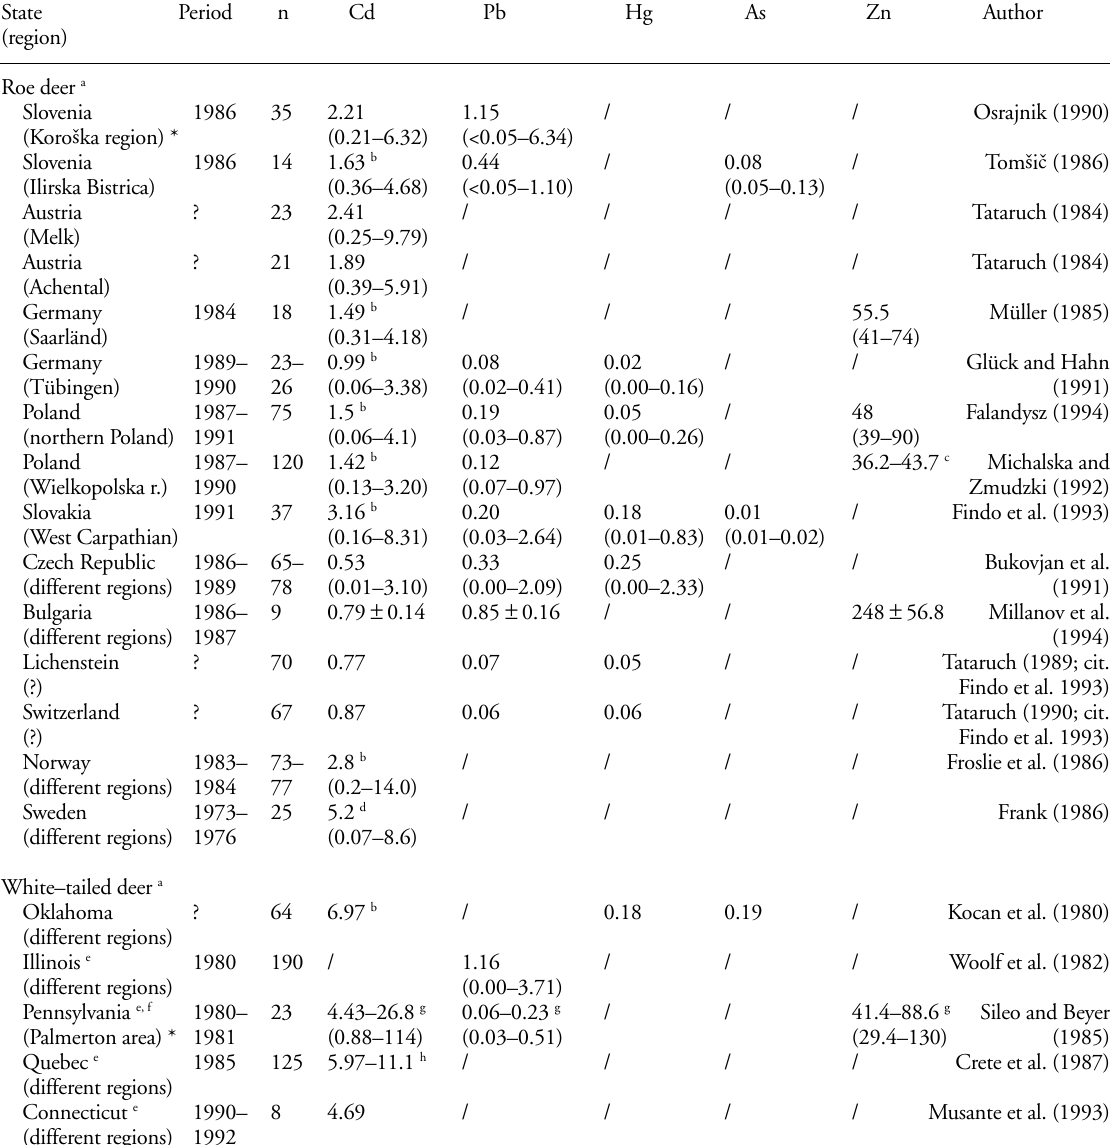
Table 7. Levels of Cd, Hg, As and Zn in kidneys and Pb in liver of roe deer in some European countries and white-tailed deer in the North America (mg kg –1 wet weight). Arithmetic means with range in parenthesis (where available) are